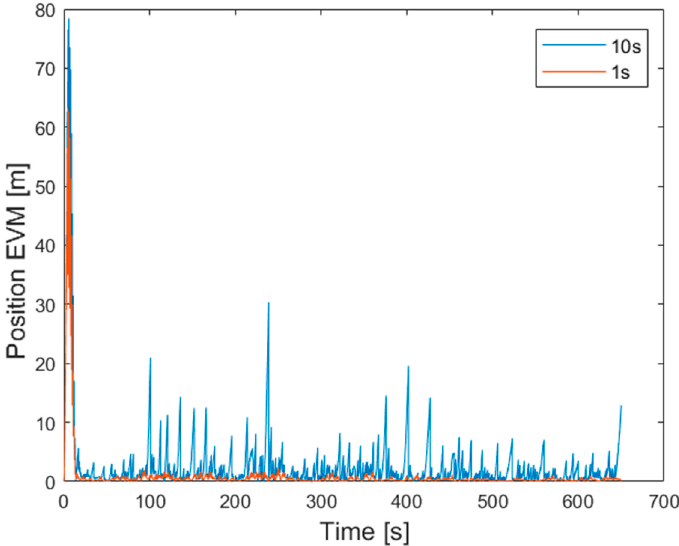
Figure 15. Differences of position in 1s (red) and 10s (blue) of outages. Table 6. RMSE of position EVMs for different GNSS outages.